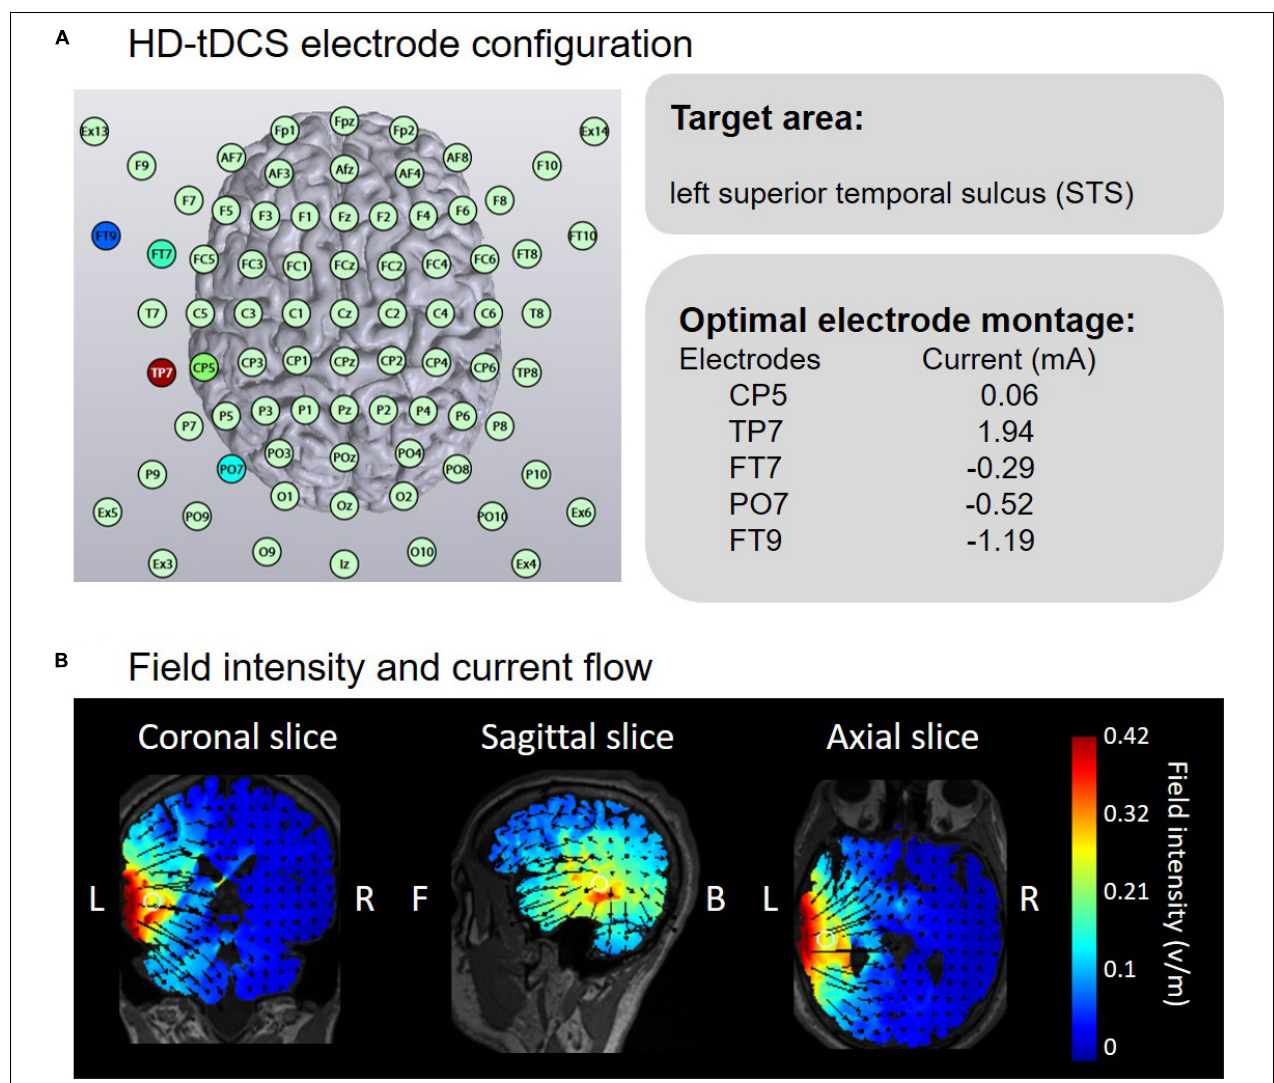
FIGURE 4 | Electrode configuration and simulated electric field in anodal HD-tDCS over the left STS. (A) HD-Targets software defined the optimal electrode montage to optimize the focality on the left STS. (B) HD-Explore software modeled the field intensity and current